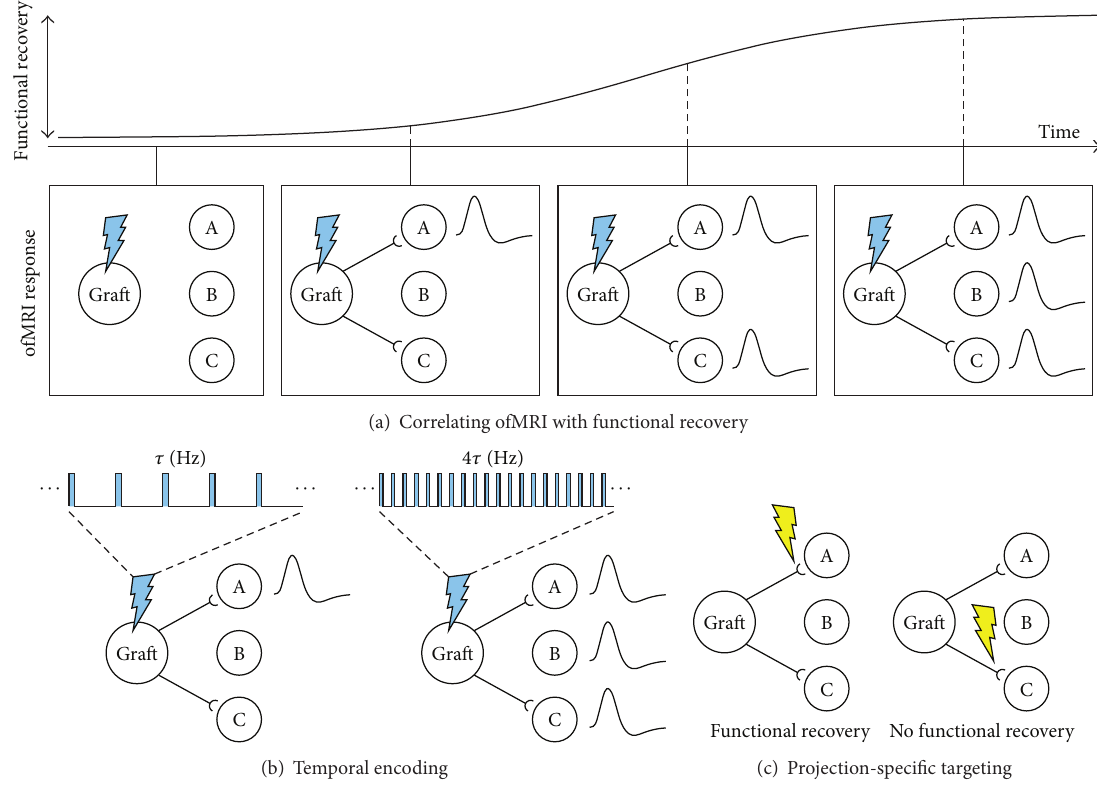
Figure 1: Optogenetic control of neuronal grafts and its combination with fMRI can be used to characterize dynamic graft-host interactions and shed light on neuronal circuit mechanisms underlying functional recovery. (a) The noninvasive nature of ofMRI allows longitudinal studiestobeperformedinparallelwithbehavioralassessmentsoffunctionalrecovery.Thiscartoonillustratesanexampleinwhichstimulation of engrafted neurons evokes activity in more downstream regions (represented as nodes A, B, and C) over time. Hemodynamic response functions are shown as insets to indicate the presence of fMRI signal modulations. These functional connections can be matched to behavioral readouts, providinginformation onwhich graft-hostbrainnetworks underliefunctional recovery. Inthisexample, thegraftexhibits structural integration and sends projections to two remote regions (nodes A and C). However, the time courses over which these projections influence network activity can differ. Eventually, stimulation can even result in the modulation of a region that does not receive direct projections from the graft itself (node B) but is influenced polysynaptically by the graft-host-host network. (b) Similar to endogenous neuronal populations, engrafted neurons may exert different effects on downstream brain regions depending on the specific temporal pattern of their firing. ofMRI enables precise temporal patterns to be played into the graft while imaging whole-brain activity. This cartoon illustrates an example in which the frequency of stimulation causes the engrafted neurons to modulate the activity of additional downstream regions when stimulation frequency is increased. (c) Projection-specific targeting enables the role of particular graft-host projections to be studied. In this cartoon, for example, functional recovery occurs when the graft-to-A projection in inhibited but does not occur when the graft-to-B projection is inhibited. Experimental paradigms like this can be used to infer which projections are necessary for functional